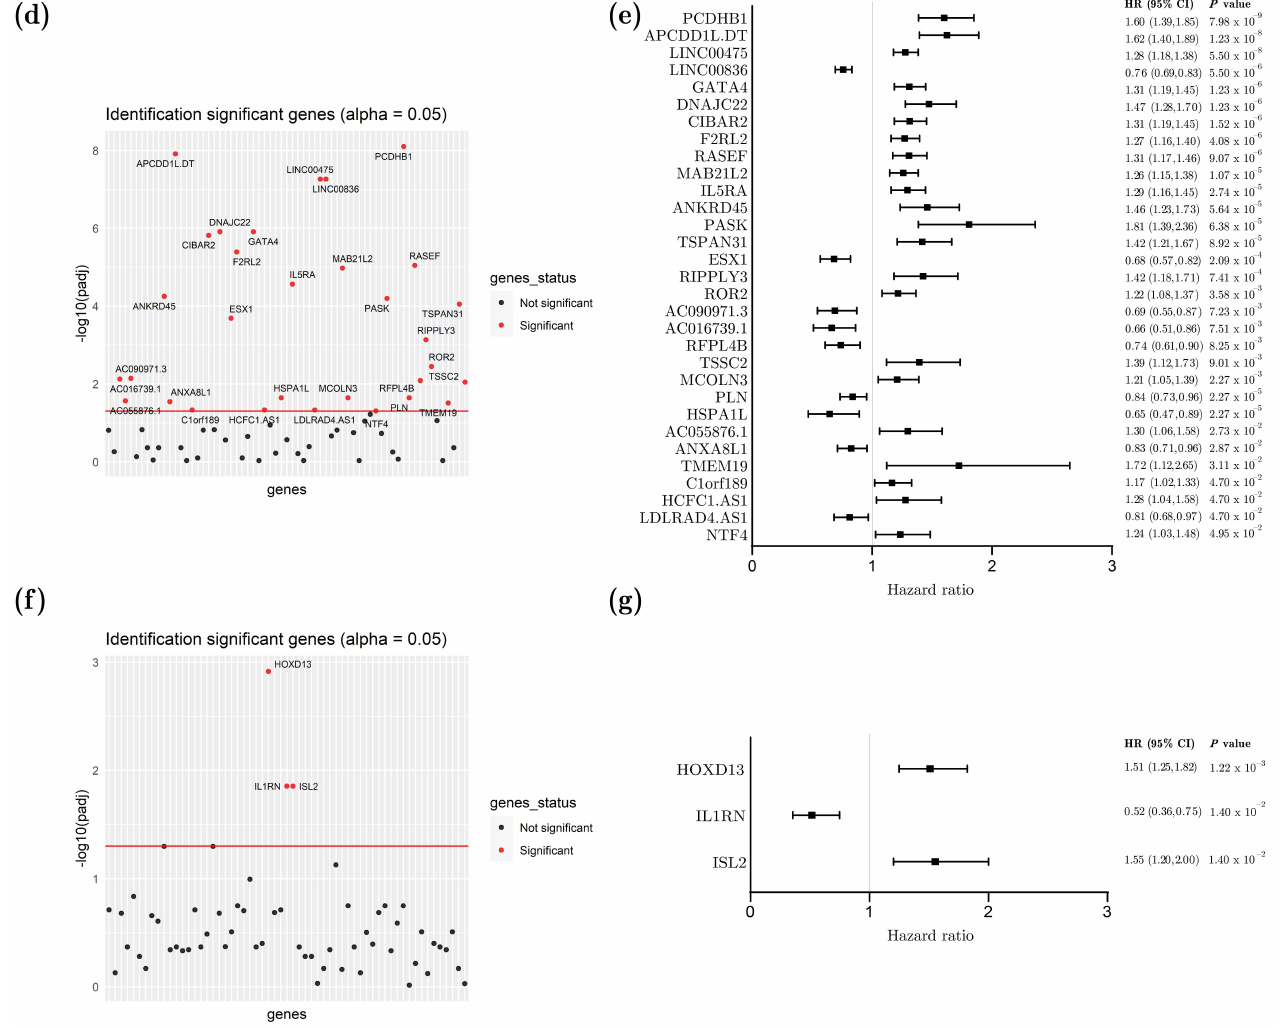
Figure 2. Male-over-female differentially expressed genes (DEGs) associated with patient survival in grade 2 and 3 glioma samples from TCGA. Venn diagram comparing the 117 and 120 male over- female DEGs from either grade 2 or grade 3 samples, respectively ( a ). Manhattan plots representing the association between gene-expression level and patient survival in the univariate analysis of grade 2 ( b ), grade 3 ( d ), and grade 3 IDHmut ( f ) gliomas. Red line marks significance threshold where the p -value adjusted by the Benjamini–Hochberg method is equal to 5%. Forest plot representing the hazard ratio (HR) and its confidence interval (CI) of genes with expression that is associated with patient survival in univariate analysis of grade 2 ( c ), grade 3 ( e ), and grade 3 IDHmut ( g )